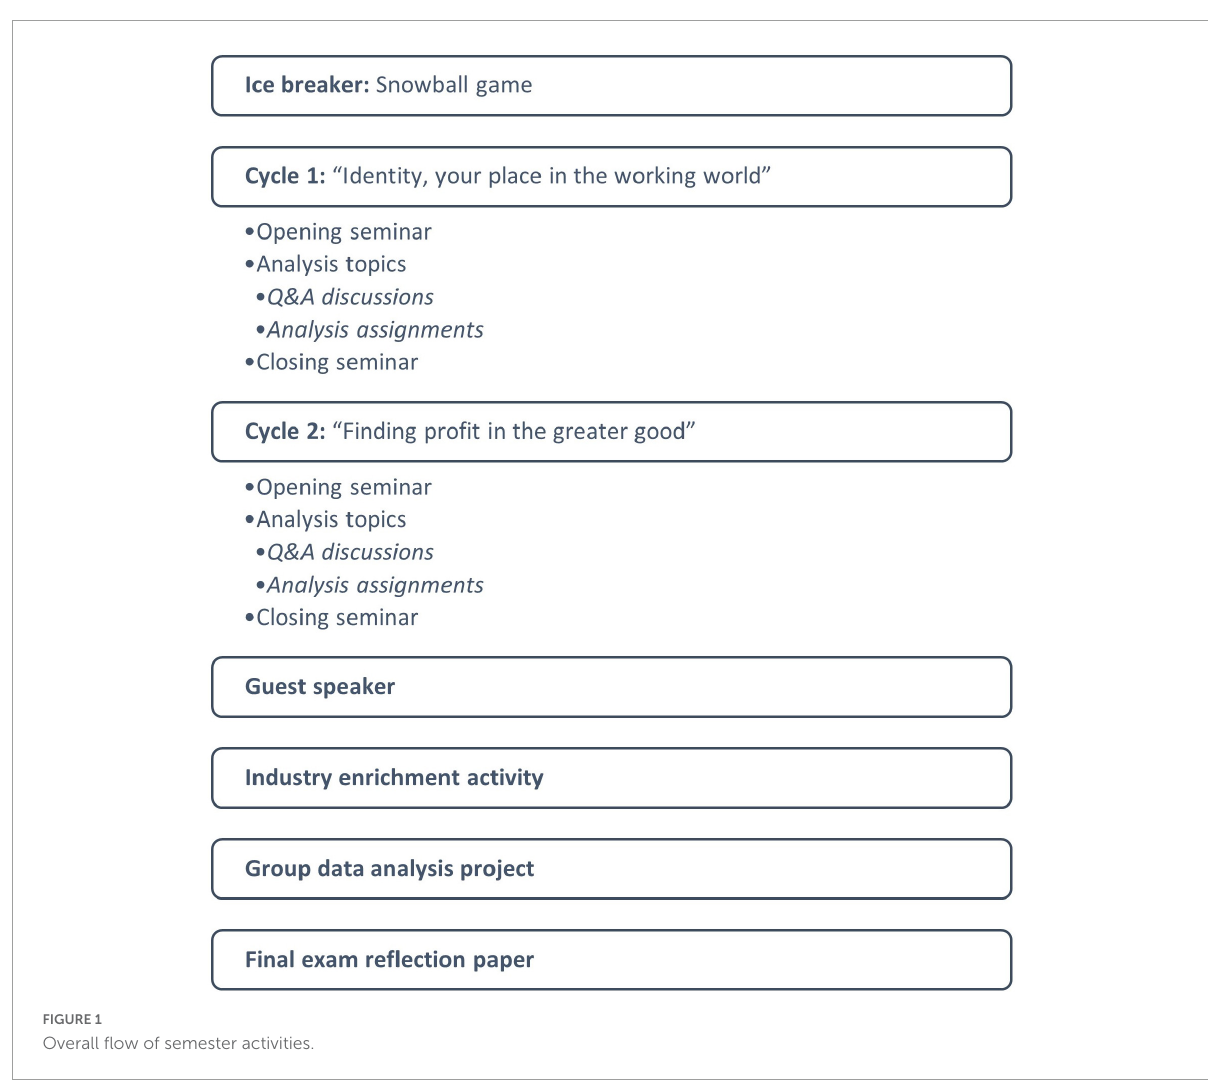
FIGURE1 Overall flow of semester activities.